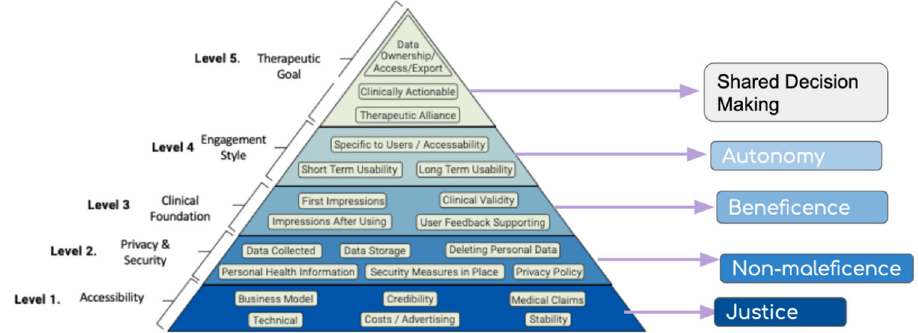
Fig. 1 APA Framework. The pyramid depicts the APA Framework and the ethical principle corresponding to each